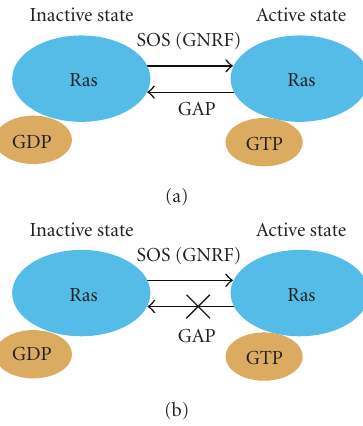
Figure 2: Activity states of the KRAS protein. Mutational change in exon 1 of KRAS leads to permanent “on”